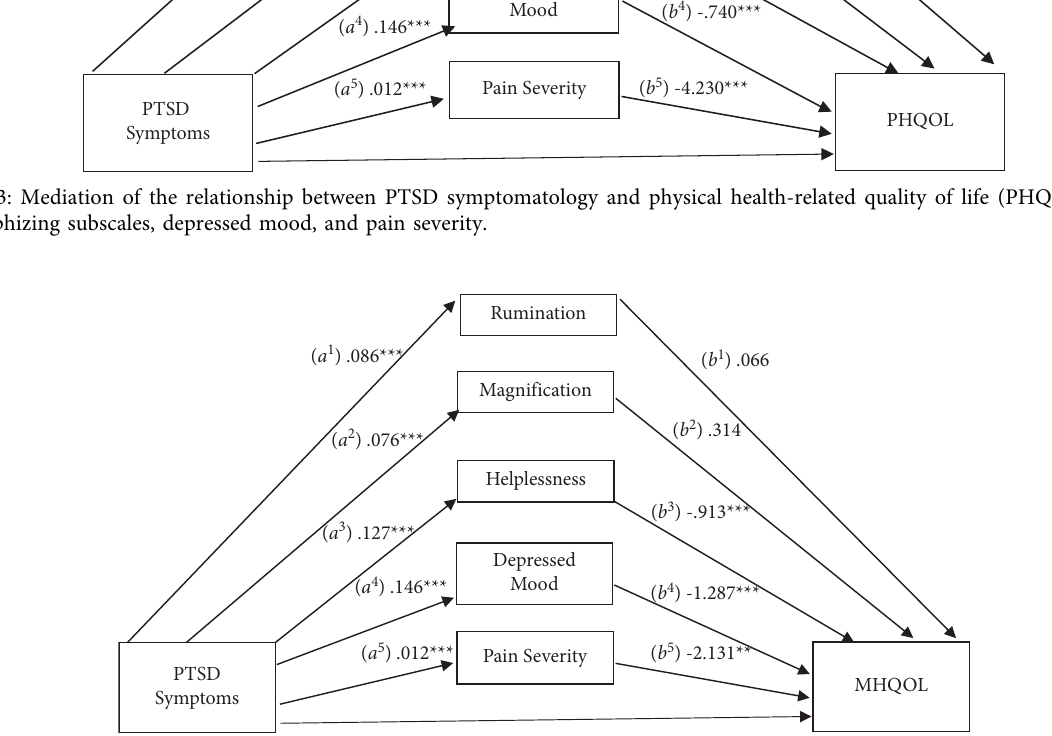
Figure 4: Mediation of the relationship between PTSD symptomatology and mental health-related quality of life (MHQOL) by pain catastrophizing subscales, depressed mood, and pain